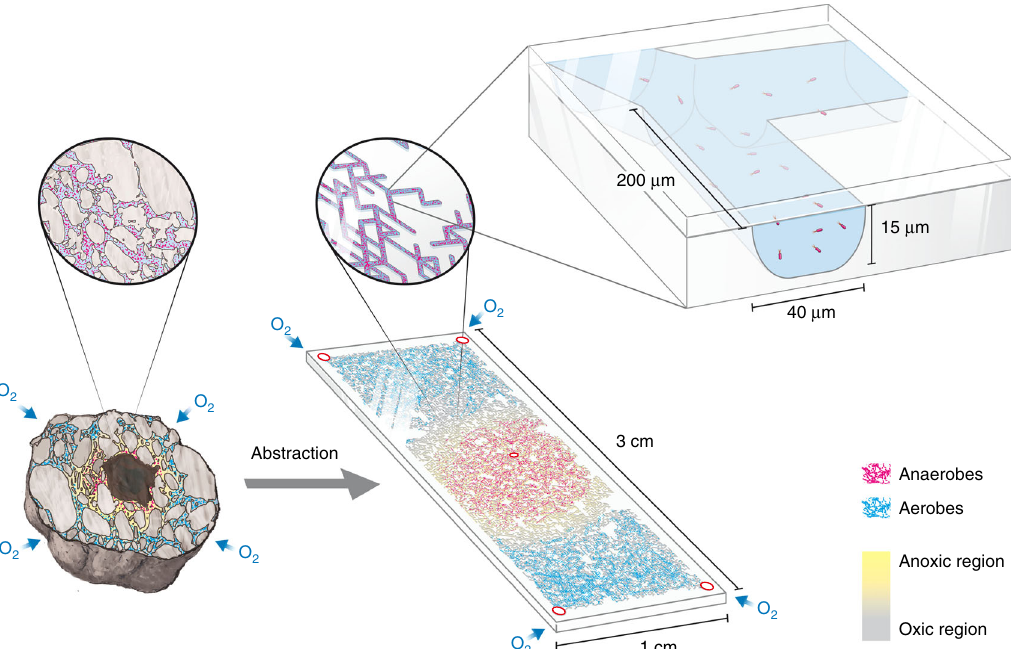
Fig. 1 Conceptual view of a model pore network. Aerobes (blue) and anaerobes (red) spatially segregate in a natural soil aggregate due to anoxic conditions at the core (illustrating a central carbon source and oxygen diffusing from the aggregate outer surface). Glass-etched micrometric 2-D pore networks mimicking an idealized cross-section in a soil aggregate were used in the experiments. Chemical boundary conditions similar to those postulated for saturated soil aggregates within an unsaturated soil were imposed via 5 ports allowing access to an otherwise sealed pore network. The pore network geometry allows nutrient diffusion through saturated pores and ample space for bacterial fl agellated motility. The emerging spatial self-organization of the two microbial species due to opposing nutrient sources and locally modi fi ed gradients can be directly visualized and quanti fi ed using fl uorescence microscopy through the transparent glass